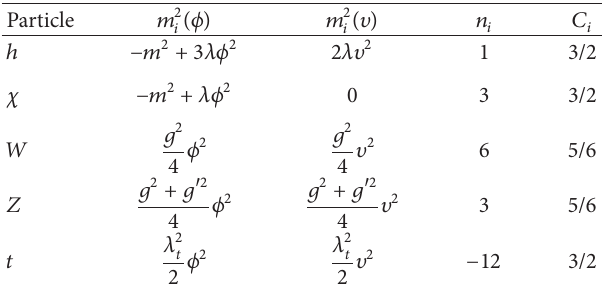
Table 1: The 𝜙 -dependent squared masses 𝑚 2 𝑖 (𝜙) and the number of degrees of freedom 𝑛 𝑖 for particle 𝑖 in SM. 𝑚 2 𝑖 (𝜙 = 𝑣) gives the physical masses for 𝑣 = 246 GeV, which is the vacuum expectation value of the Higgs field. 𝐶 𝑖 are given for MS scheme. We include the contributions coming from the Higgs boson ℎ , the would-be Nambu-Goldstone bosons 𝜒 , the gauge bosons 𝑊 and 𝑍 , and the top quark 𝑡